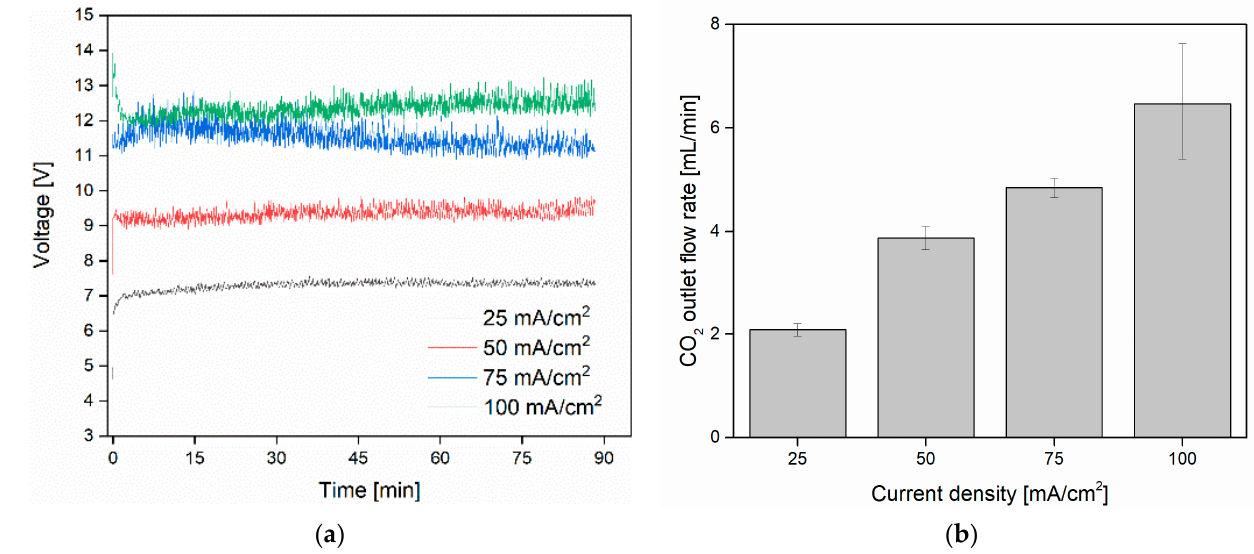
Figure 2. ( a ) Measured voltages for different applied current densities (experimental conditions: Q inlet = 20 mL/min, Q pump = 1 mL/min, CO 2 /N 2 ratio = 100%/0%). ( b ) Average CO 2 flow for different applied current densities with the same experimental conditions.